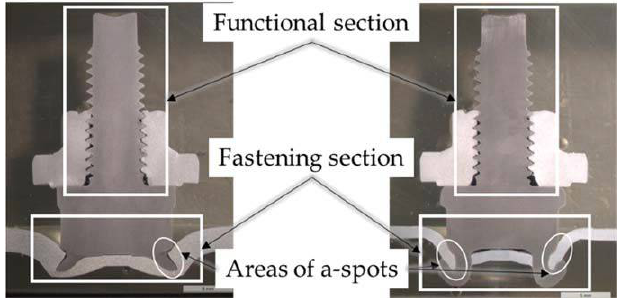
Figure 2. Functional elements of self-piercing threaded